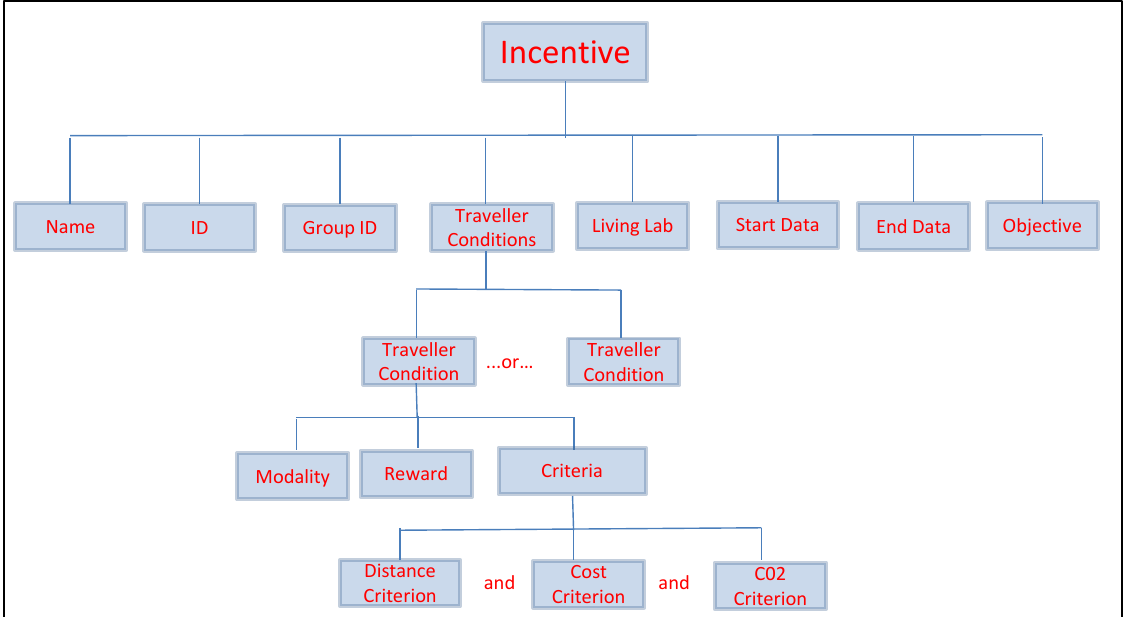
Figure 4. Distributing challenges and rewards to the Android tripzoom app.